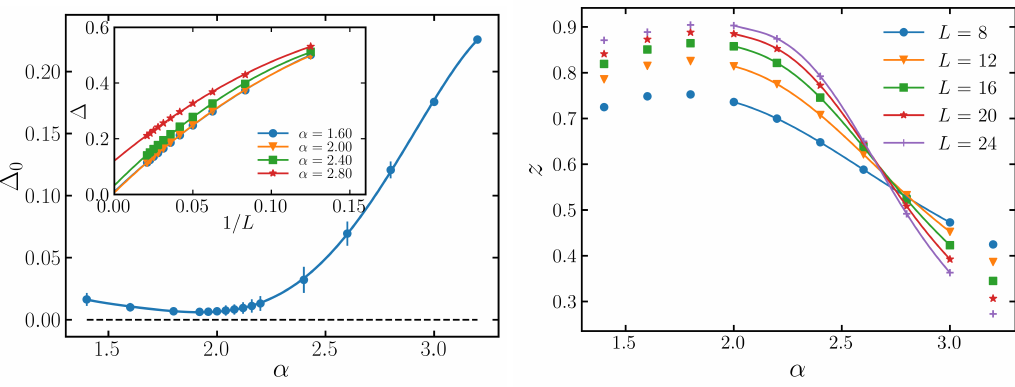
Figure 5: (left) Gap extrapolated to the thermodynamic limit as a function of α . The inset shows the finite-size gaps, obtained with DMRG, used in the extrapolation of ∆ with second order polynomial fit. (right) Dynamic critical exponent z ( L ) as 0 a function of α for various system sizes. The circles correspond to z ( L ) calculated using the gaps obtained from DMRG. The curves are the best fit using fourth order